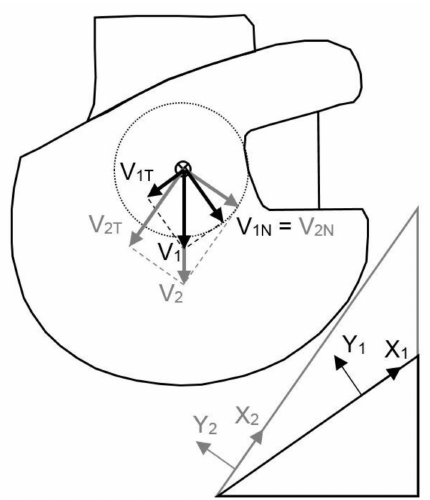
Figure A2. Impact velocities diagram. Modifying the angle of the anvil and the impact speed, the tangential component of the impact velocity can be modified keeping the magnitude of the normal component.